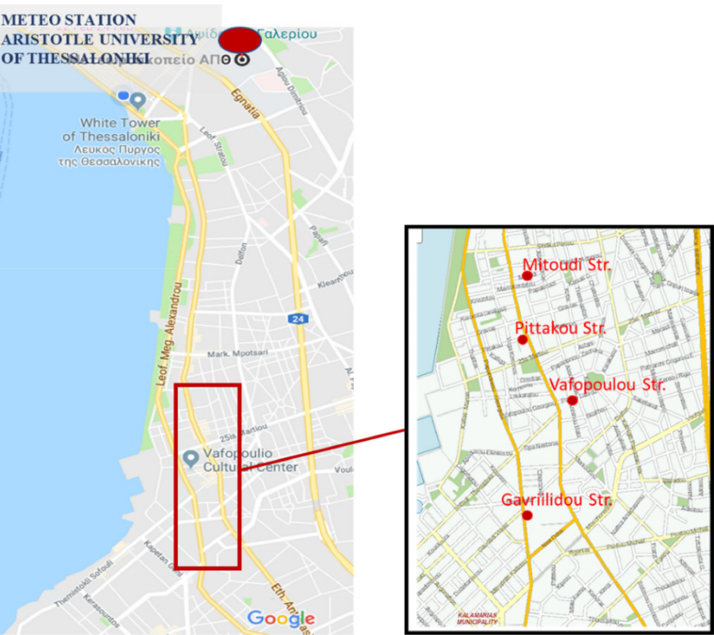
Figure 1. Relative locations of the selected urban districts and the reference location of the meteoro- logical station on the Aristotle University campus.